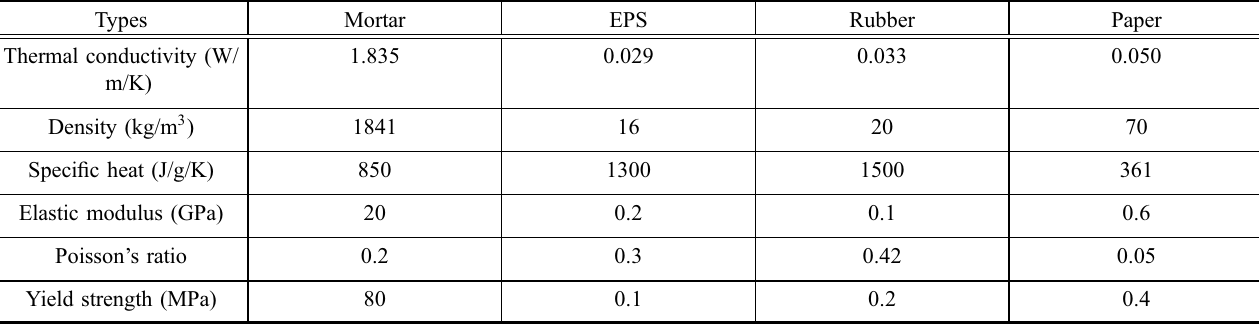
Table 1 Physical properties of insulation materials.